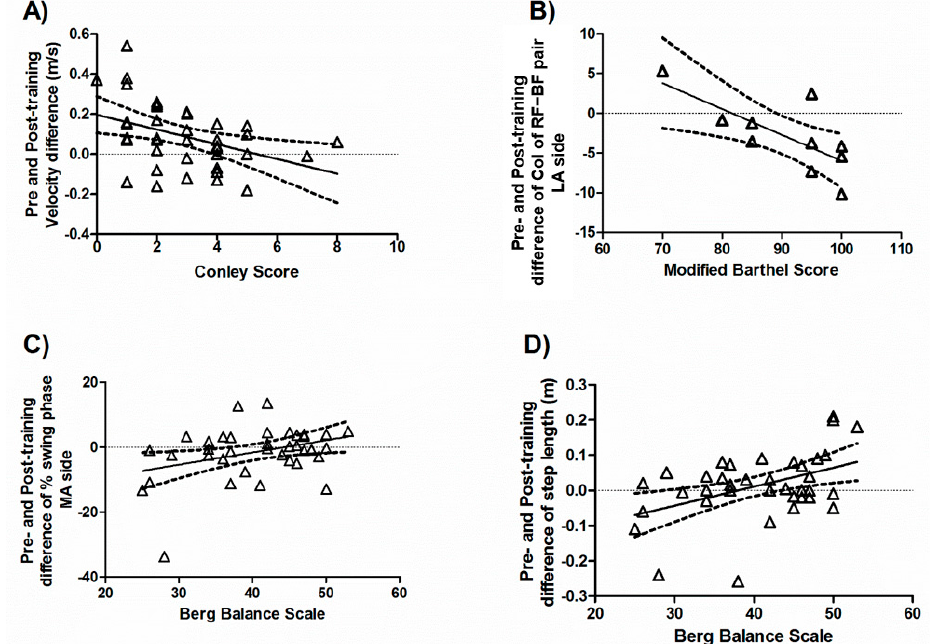
Figure 2. Correlation between the baseline clinical measures and the post-training improvements. Baseline scores of Conley Scale ( A ), Modified Barthel Index ( B ), and Berg Balance Scale ( C , D ) were correlated with changes of instrumental gait measures.